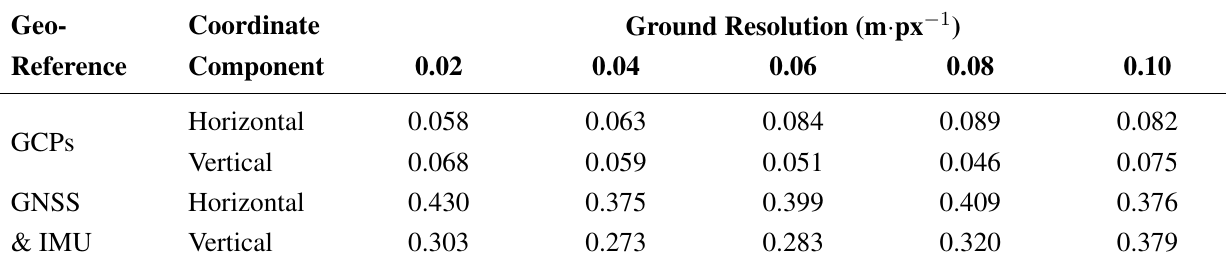
Table 3. Resulting root mean squared errors (m) (RMSE) at ground control point (GCP) locations for indirectly (GCP-based) and directly (GNSS- and IMU-based) geo-referenced imagery at Z32 for all image ground